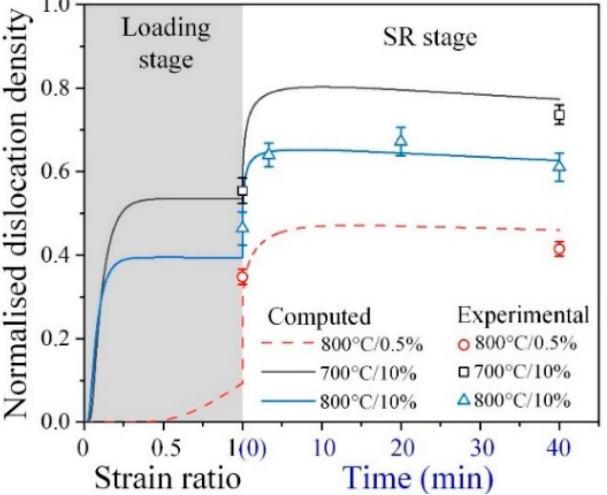
Figure 12. Comparison between computed (line) and experiment (symbol) of normalized dislocation density evolution in the whole stress relaxation process with different deformation conditions.